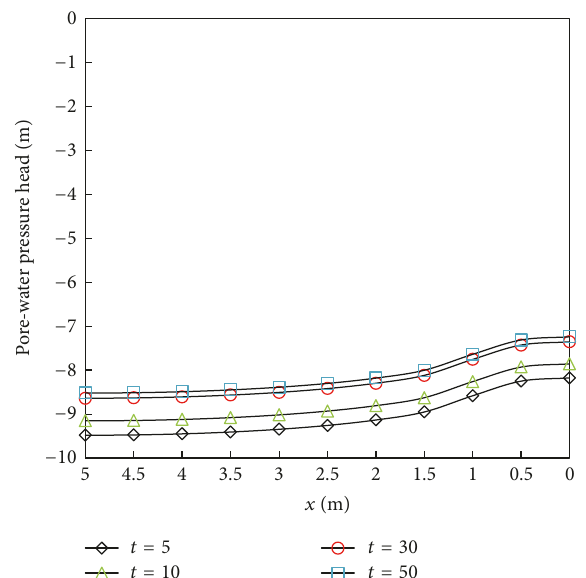
Figure 5: The pore-water pressure head at the boundary 0B with infiltration time.